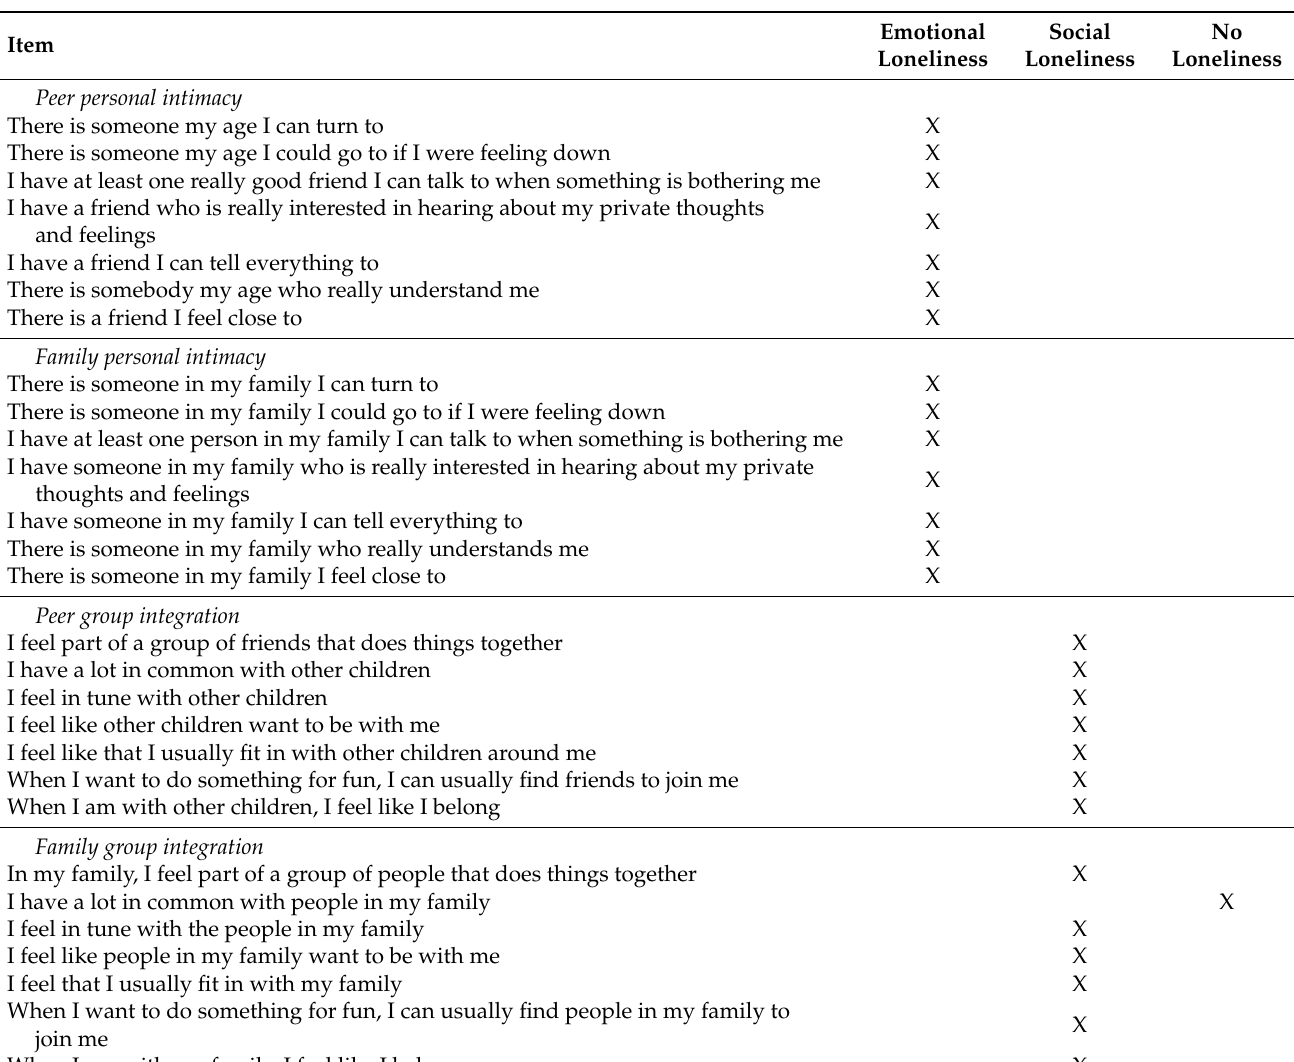
Table 7. Coding of Items of the Relational Provisions Loneliness Questionnaire